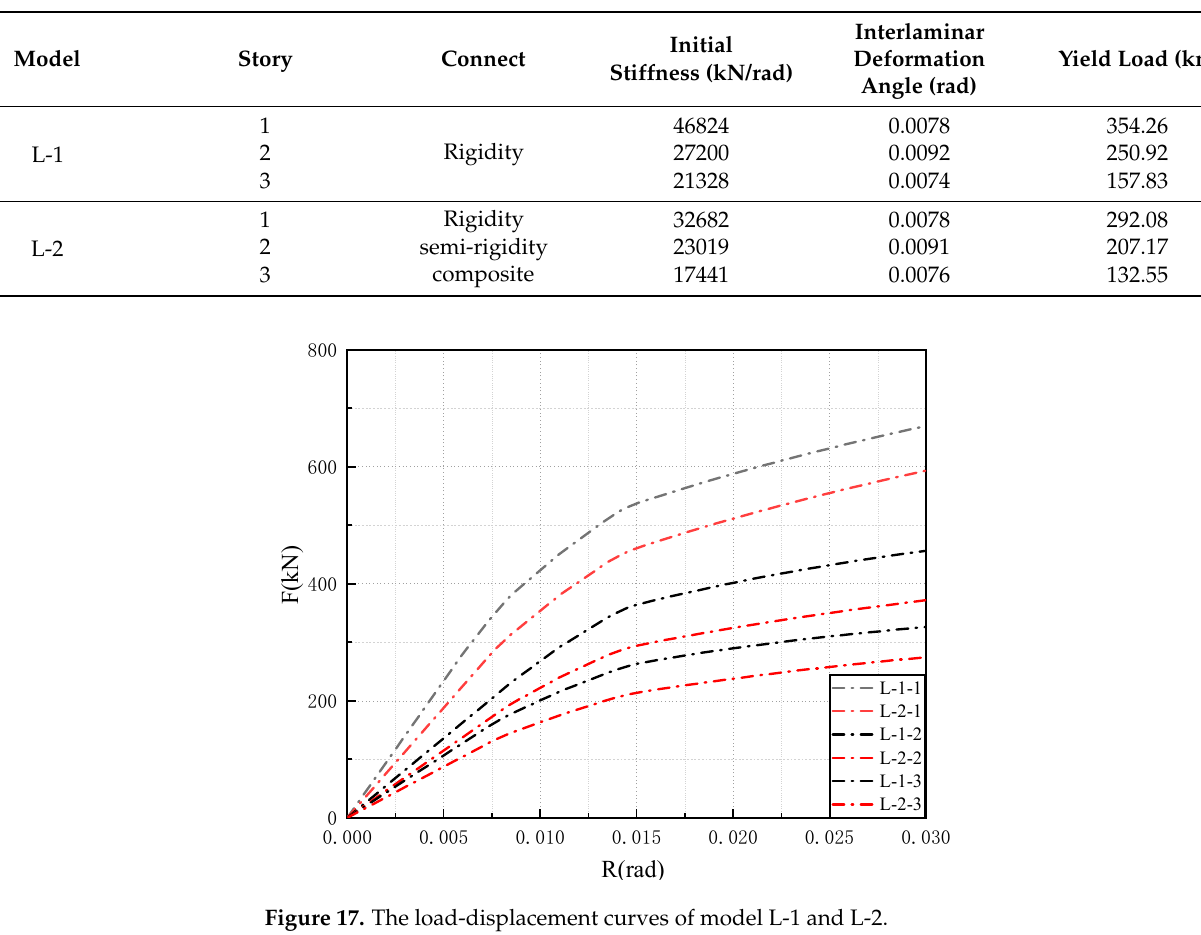
Table 6. Push-over analysis results.